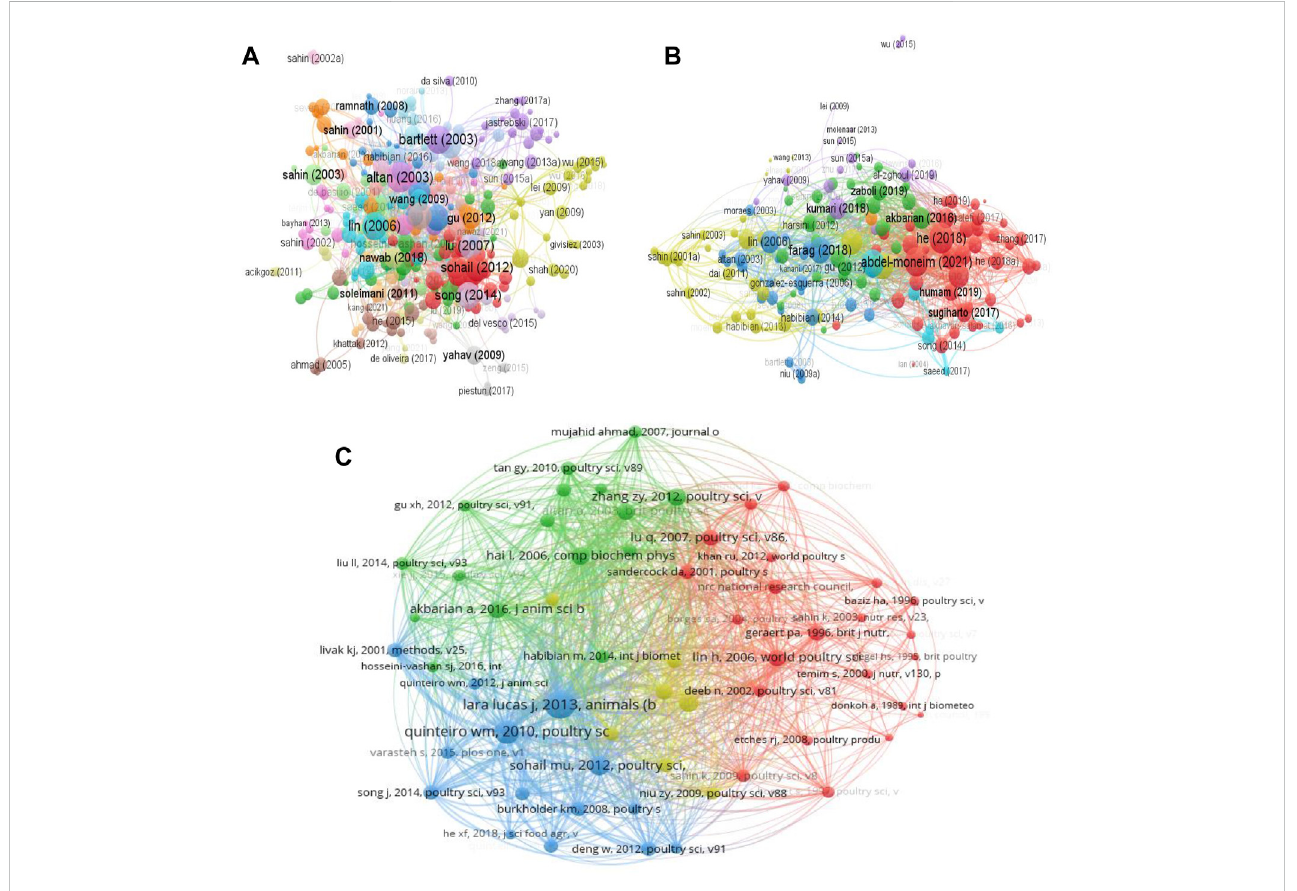
FIGURE 8 Network visualization of documents on heat stress in poultry. (A) Citation analysis of documents. (B) Bibliographic coupling analysis of documents. (C) Co-citation network of